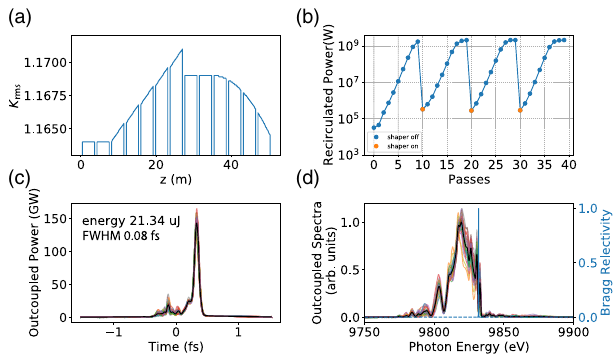
FIG. 11. Attosecond pulses outcoupling. Undulator taper con- figuration (a), recirculated peak power for each iteration (b). Here the orange dots represent the shots when the shaper is on. Thirty- five shots of outcoupled radiation from the shaped beam (c) and their spectrum (d), with the colored line for each shot and black line for the average. Bragg reflectivity, as a function of photon energy, is shown by the blue dash line in (d).